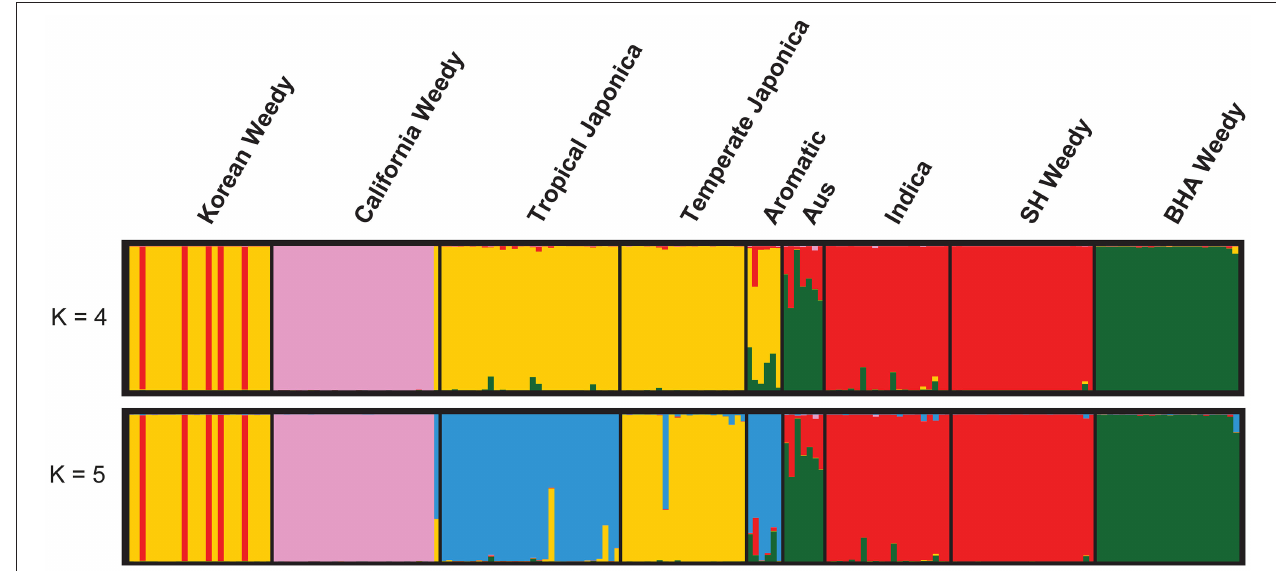
FIGURE 1 | STRUCTURE plot of five cultivated rice subgroups and four weedy rice groups. K = 4 was chosen using Delta K, while K = 5 was included as it separated temperate and tropical japonica. Korean weedy rice groups with indica (red) and temperate japonica (yellow) cultivars.